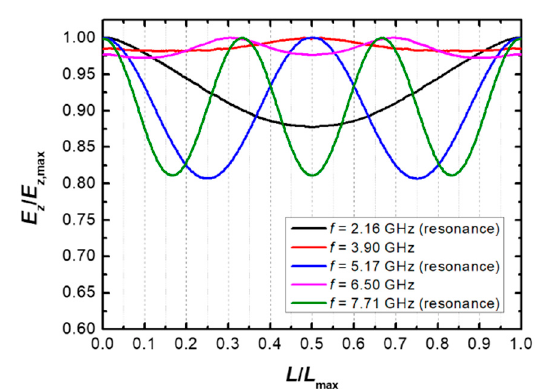
Figure 3. Normalized E z -field distribution ( E z / E z ,max ) on the detecting antenna of the RCP along normalized antenna length ( L / L max ), where the z-direction is parallel to the normal direction of the antenna surface.